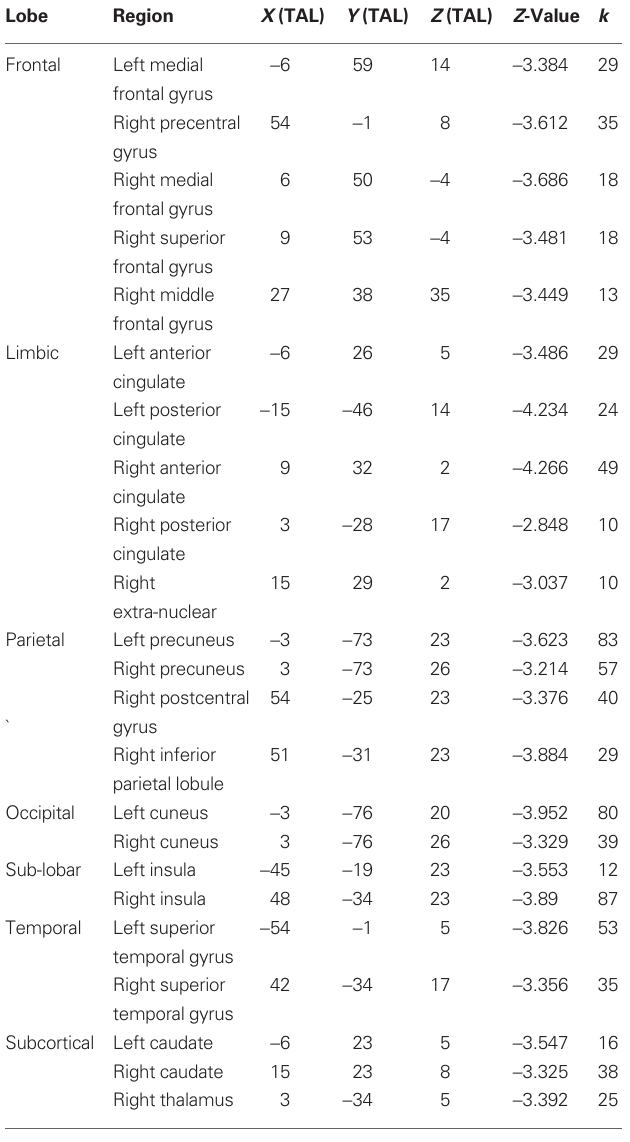
Table 2 | Functional magnetic resonance imaging activations specific to [incorrect > tool] > [correct >